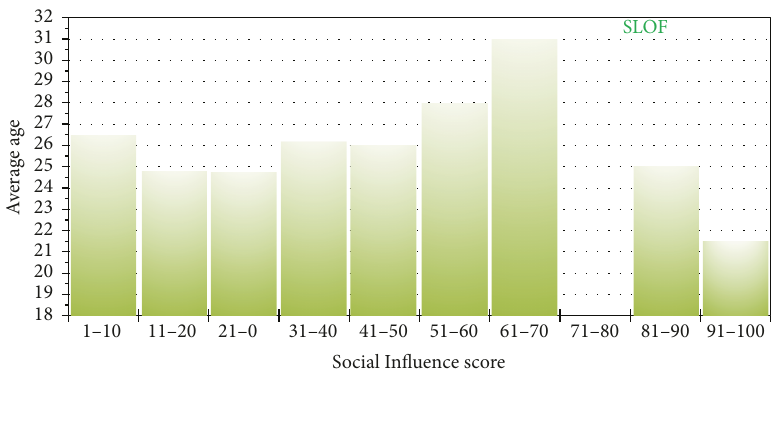
Figure 11: Average age with respect to SI scores of SLOF .